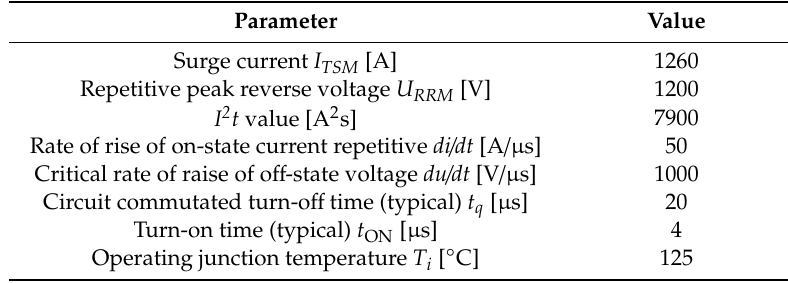
Table 1. Parameters of the Unitra-Lamina TR51-80-12-76 thyristors (Adapted from [25]).